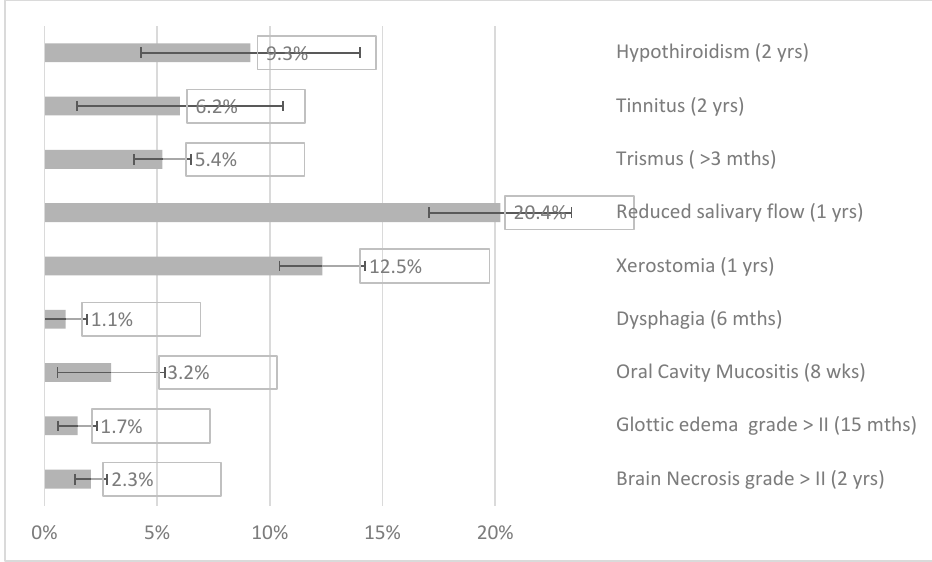
Figure 2. Δ NTCPx-p for the considered models. Missing models in the graph showed Δ NTCPx-p comparable to zero and were not plotted .